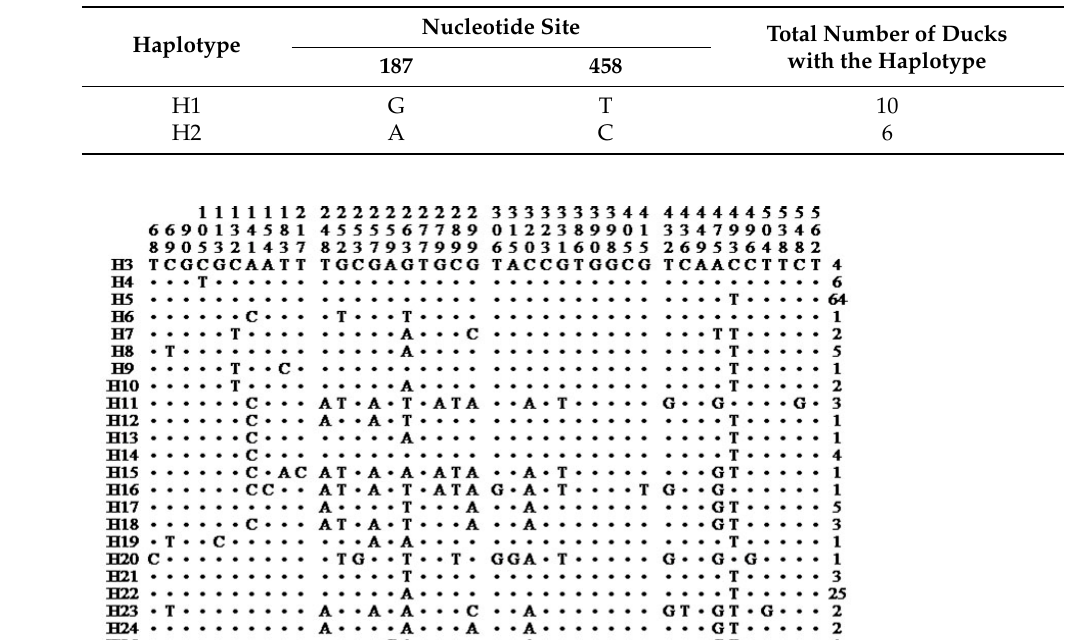
Table 2. Variable sites in mtDNA for haplotypes of Muscovy ducks.